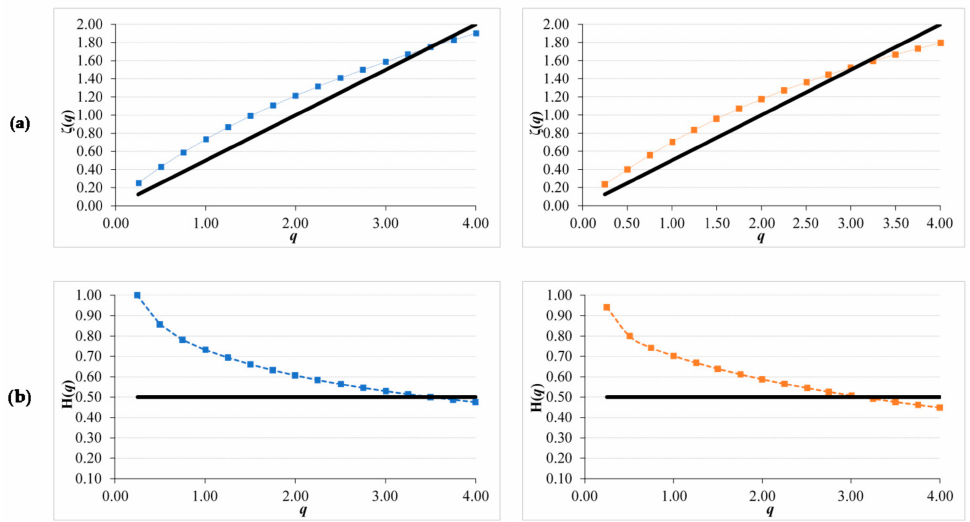
Figure 8. Generalized Structure Function plots for NDVI original series of SOM5 (left column in blue) and SOM15 (right column in red) for: ( a ) ζ ( q ) curve and ( b ) Generalized Hurst exponent H( q ), continuous line correspond to non-correlated noise with Hurst value of 0.5. Table 7. Multifractal parameters for each zone and each NDVI series. H( q = 1) generalized